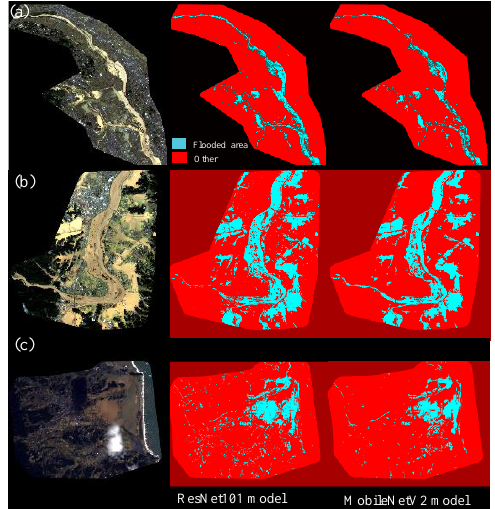
Figure 8. Comparison of flood area extraction (a). Arakawa (b). Abukumagawa (c). Utagawa © SPOT image AIRBUS DS 2019